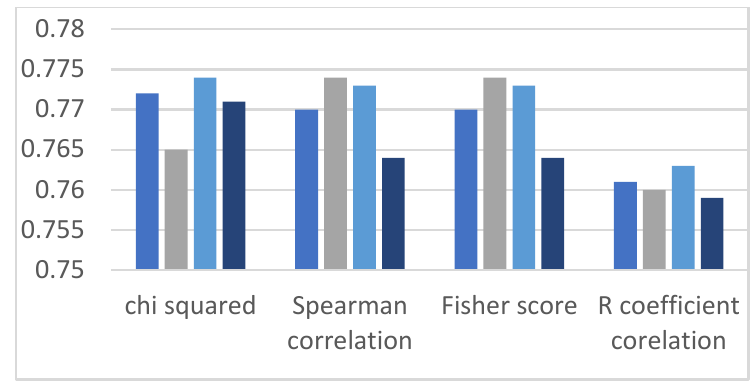
Figure 3. Accuracy using enhanced SVM.